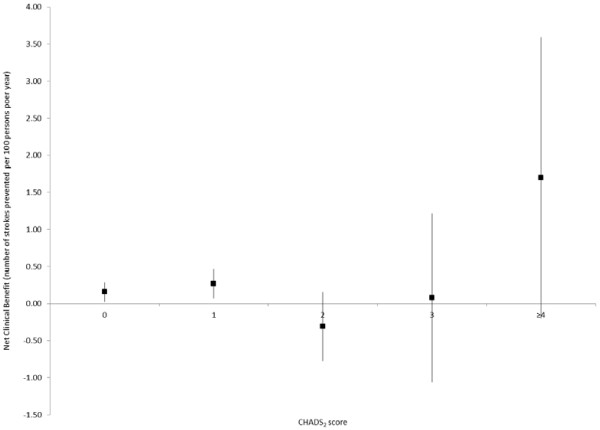
 Net clinical benefit of aspirin, stratified according to CHADS2score at baseline (based on an ICH weight of 1.5).